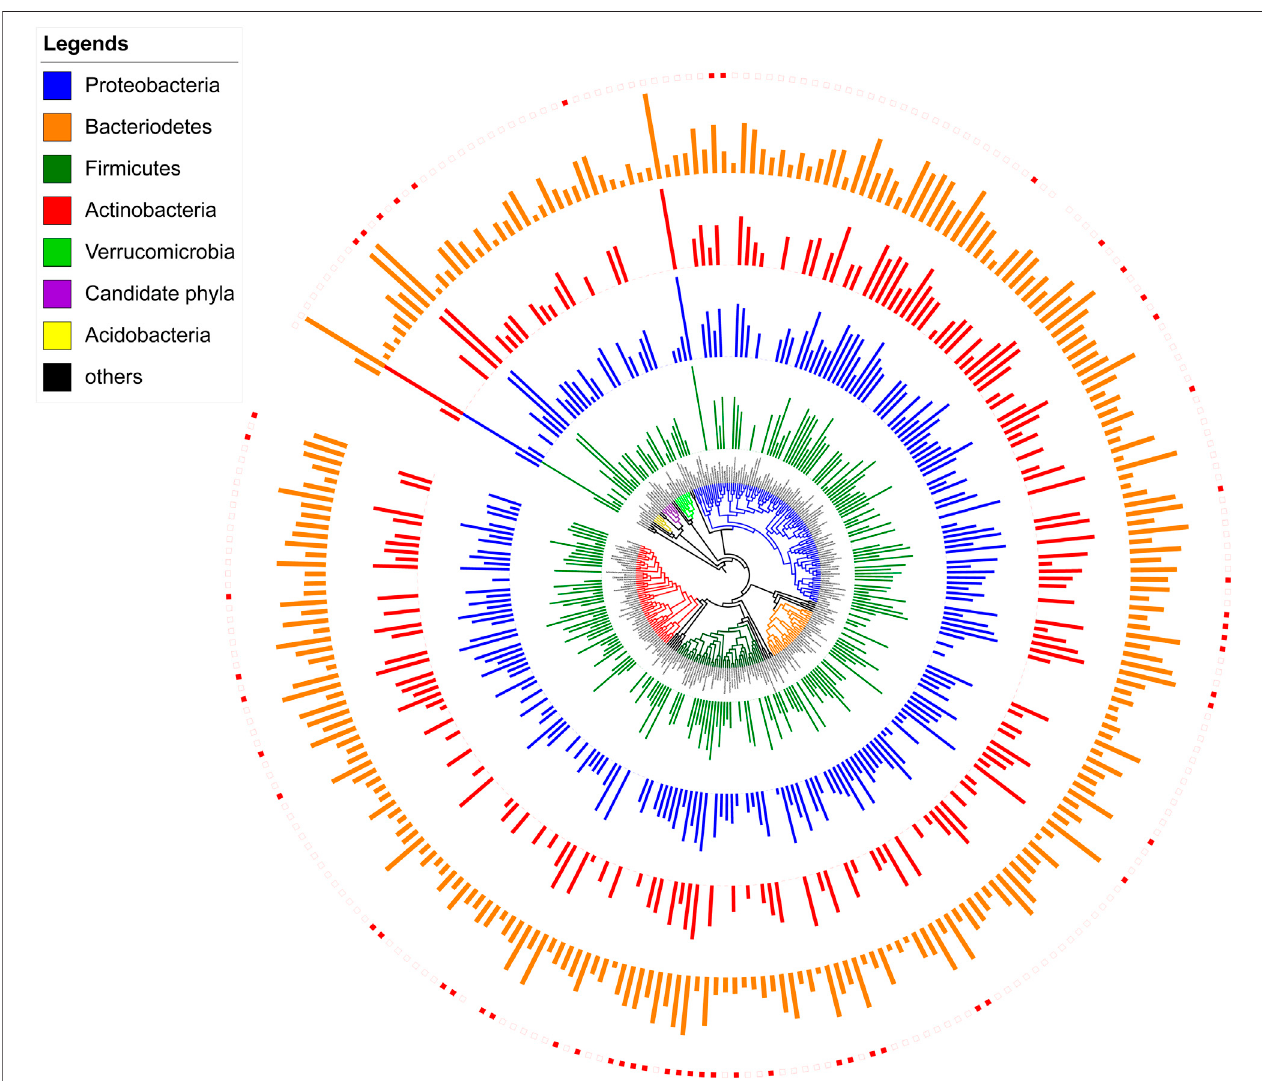
FIGURE 4 | A phylogenetic tree reconstructed from 16S rRNA sequences illustrating different bacterial taxa and their abundance from DNA within brushtail possum ’ ssaliva,depositedonthesurfaceoftheWaxTags ® .Thefourcirclesofbarssurroundingthecentralphylogeny(inred,blue,greenandorange)representthefour possums.Theheightofeachbarisproportionaltotherelativeabundanceofeachtaxon,atalogarithmicscale.Solidencirclingrectangleboxesrepresenttaxapreviously reportedfromtheoralcavityofbrushtailpossums,andclearboxesrepresentnoveltaxareportedinthisstudy.Therawdataforgeneratingthis fi gureareavailablein the Supplementary Materials , p